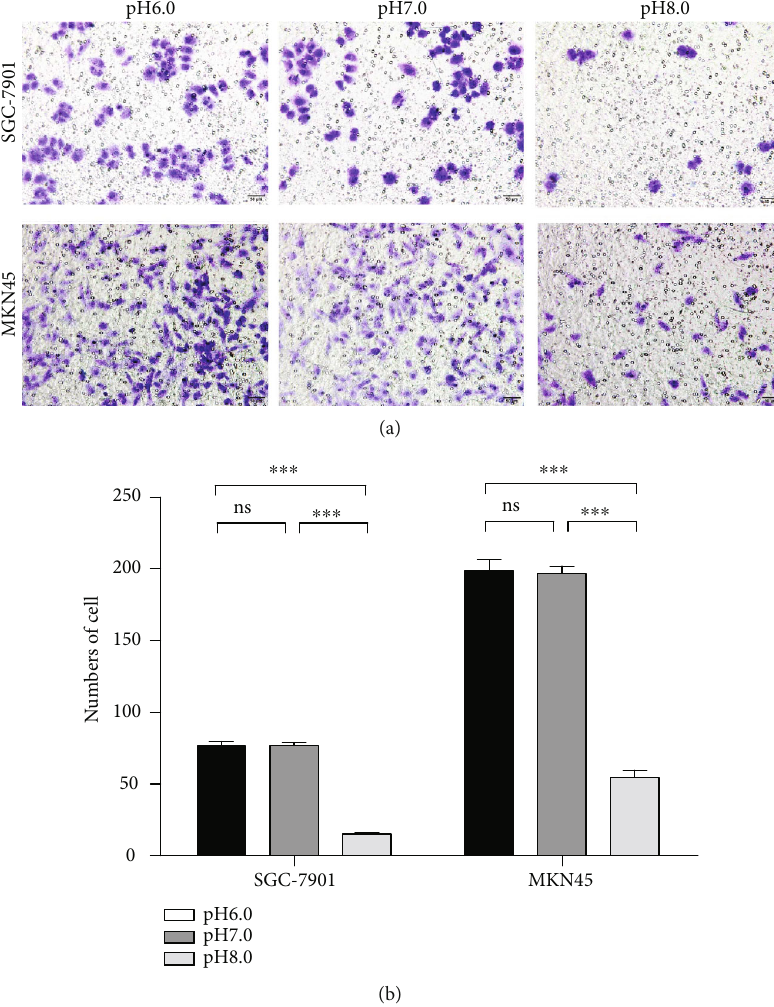
Figure 3: Alkaline microenvironment inhibited invasion of GC cells. (a) Micrograph of invasion of GC cells at di ff erent pH values (pH6.0, pH 7.0, and pH 8.0) after being cultured for 48h. (b) Analysis of invasive ability of GC cells at di ff erent pH values (pH6.0, pH 7.0, and pH8.0) after being cultured for